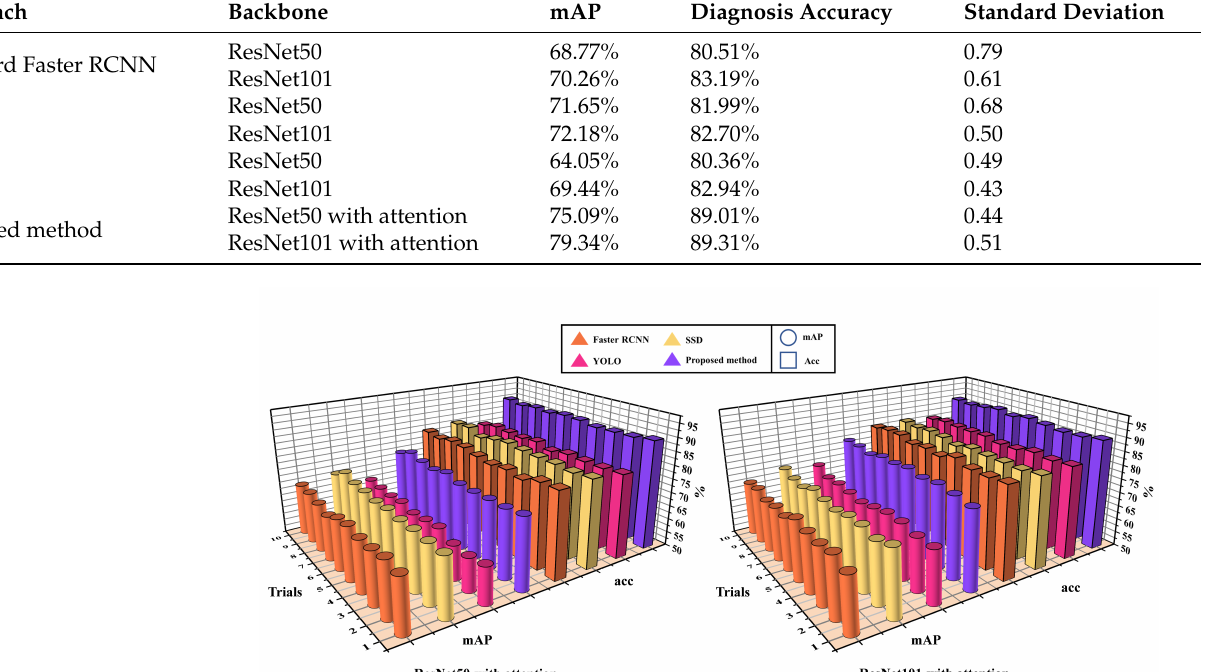
Table 8. Performance of comparison methods based on object detection.